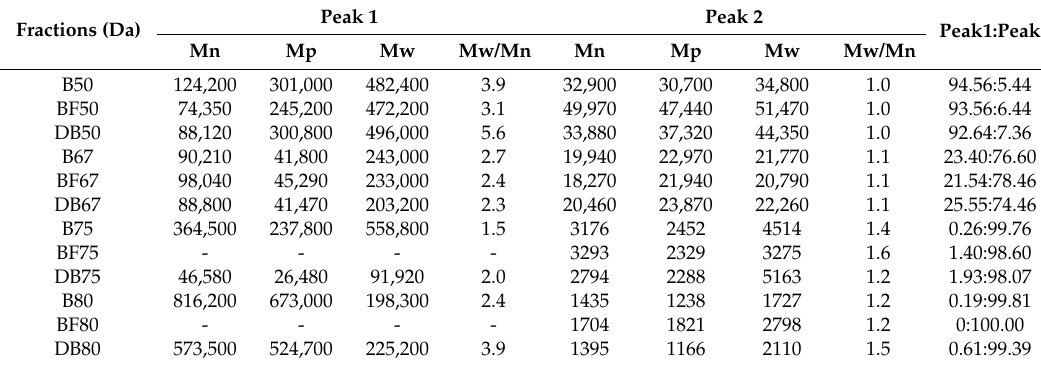
Table 5. Analysis of molecular weight of